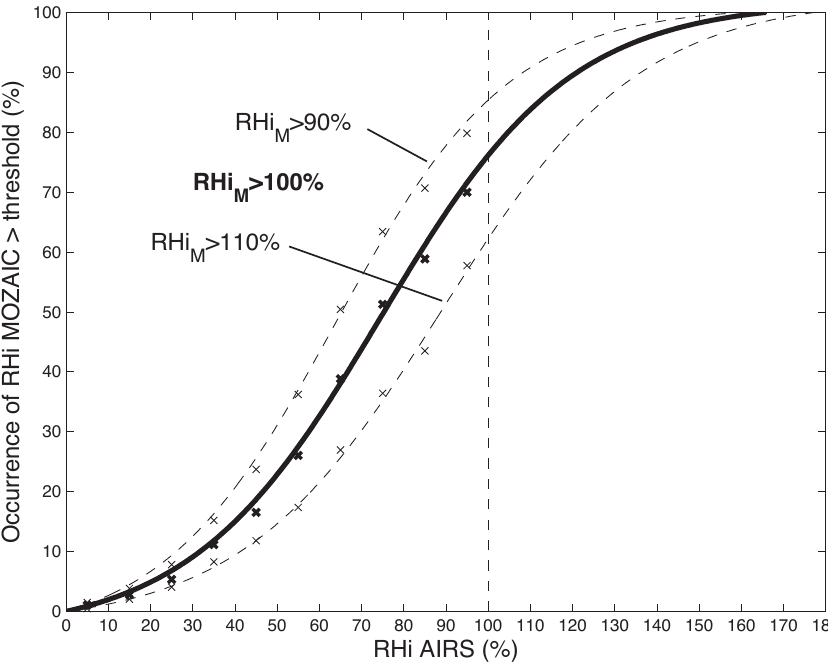
Fig. 6. Occurrence probability of ice supersaturation seen from MOZAIC as a function of AIRS relative humidity. MOZAIC supersaturation is declared when RHi M > 90%, RHi M > 100%, or RHi M >